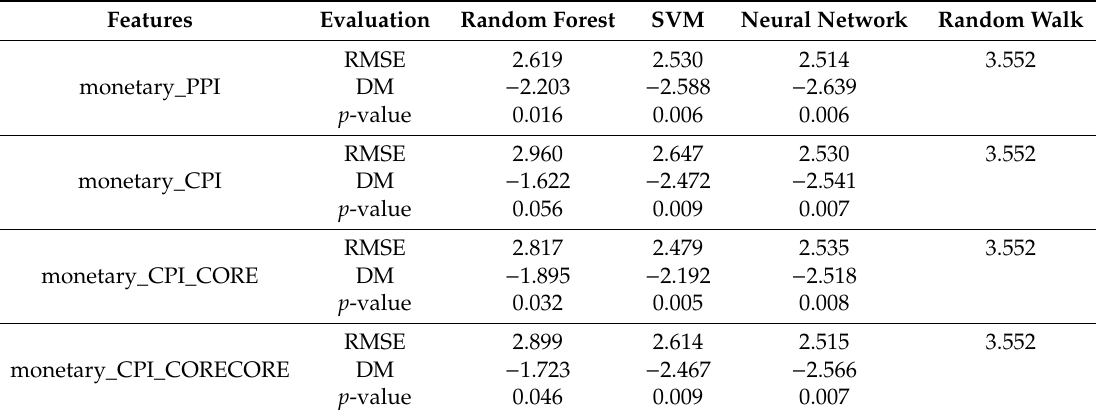
Table 4. Results for the monetary model.